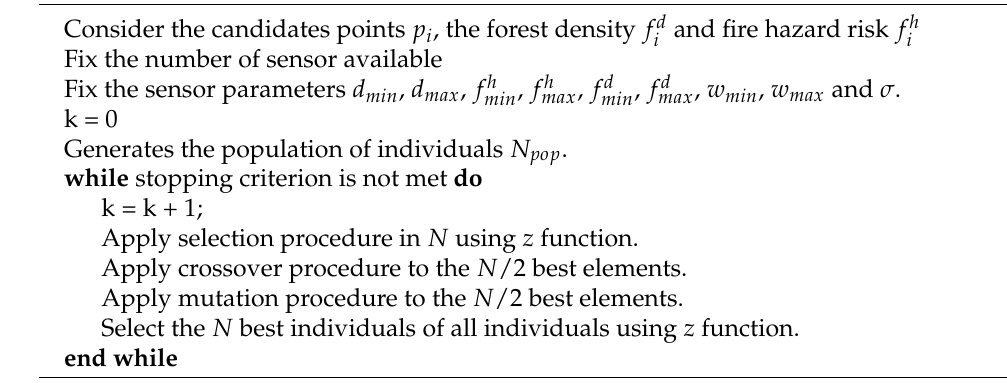
Algorithm 1 : GA to solve sensors allocation